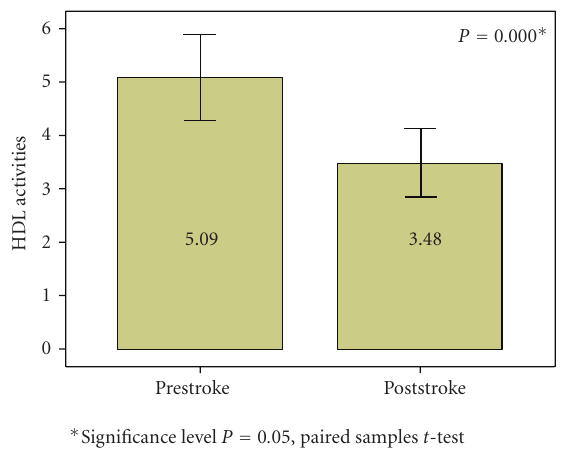
Figure 1: Mean number of HDL activities pre- and post-mild stroke for all participants ( N =